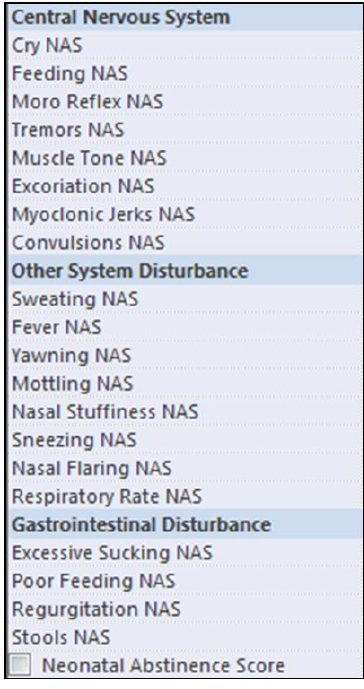
Figure 1. Modified Finnegan scoring (MFS). The current NAS scoring tool used at our NICU. Symptomatology is broadly categorized into 3 groups: central nervous system (CNS), other and gastrointestinal (GI).